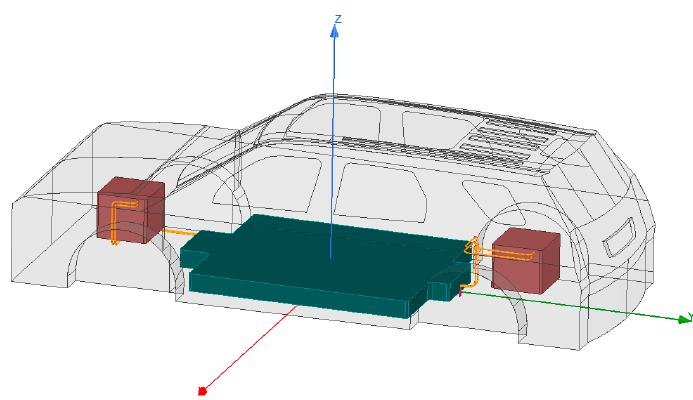
Figure 2. The EV model with two MEDS.